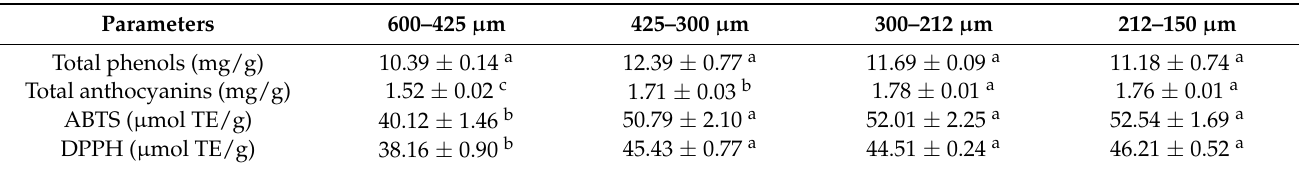
Table 1. Mean values, standard deviation and results of statistical analysis (one-way ANOVA followed by Tukey’s HSD test for multiple comparison) of polyphenol and anthocyanin total contents and antioxidant activity of the different grape pomace size powder.